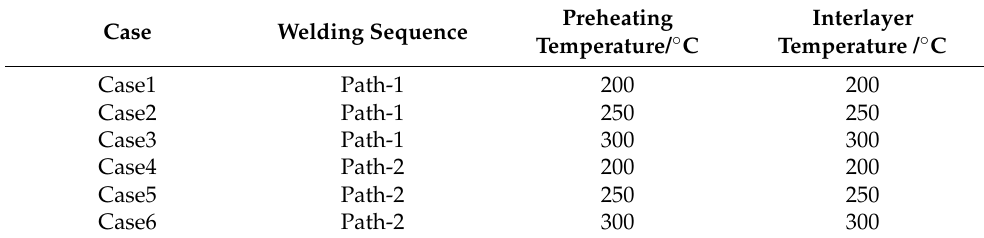
Table 3. Welding cases.